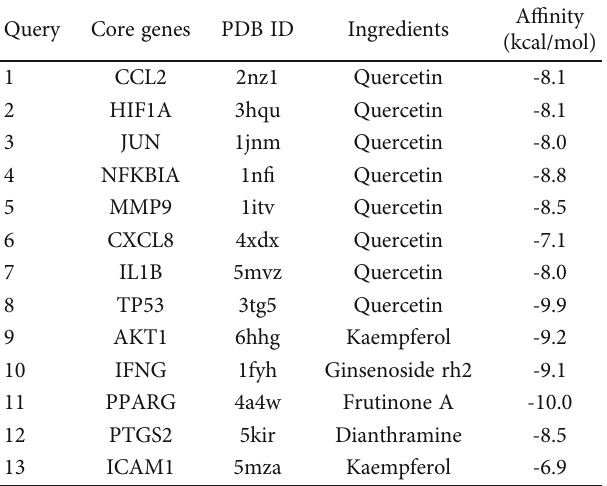
Table 1: Results of molecular